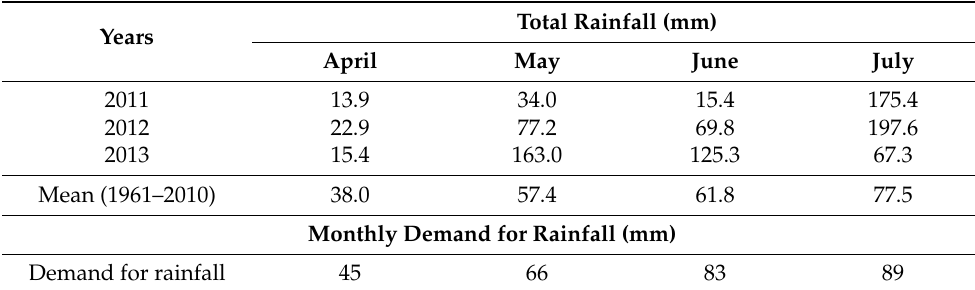
Table 1. Total rainfall and demand for